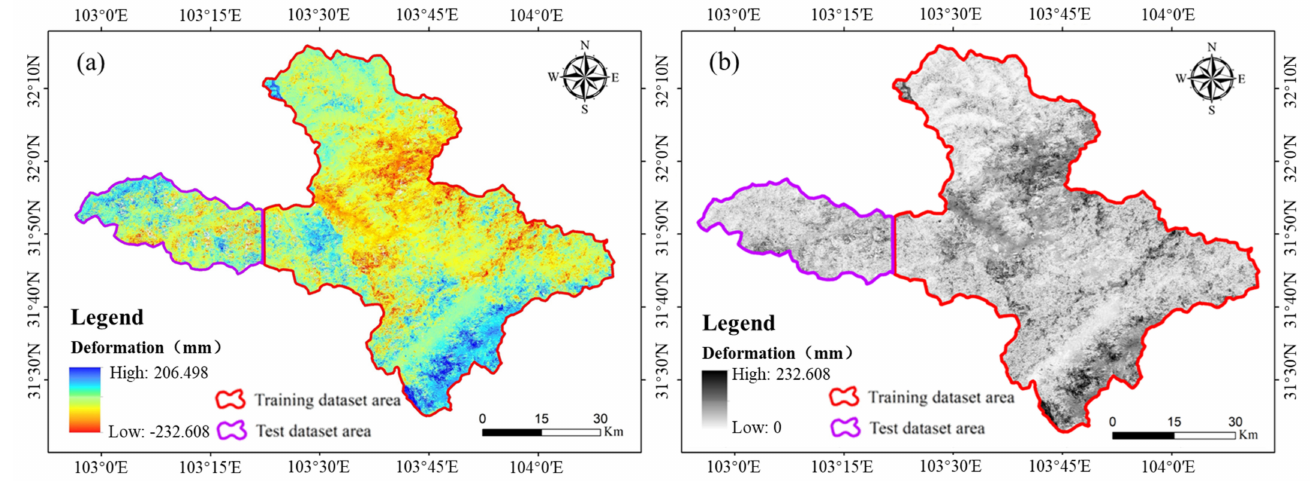
Figure 6. SBAS-InSAR deformation results obtained from the ascending orbit dataset ( a ) and the descending orbit dataset ( b